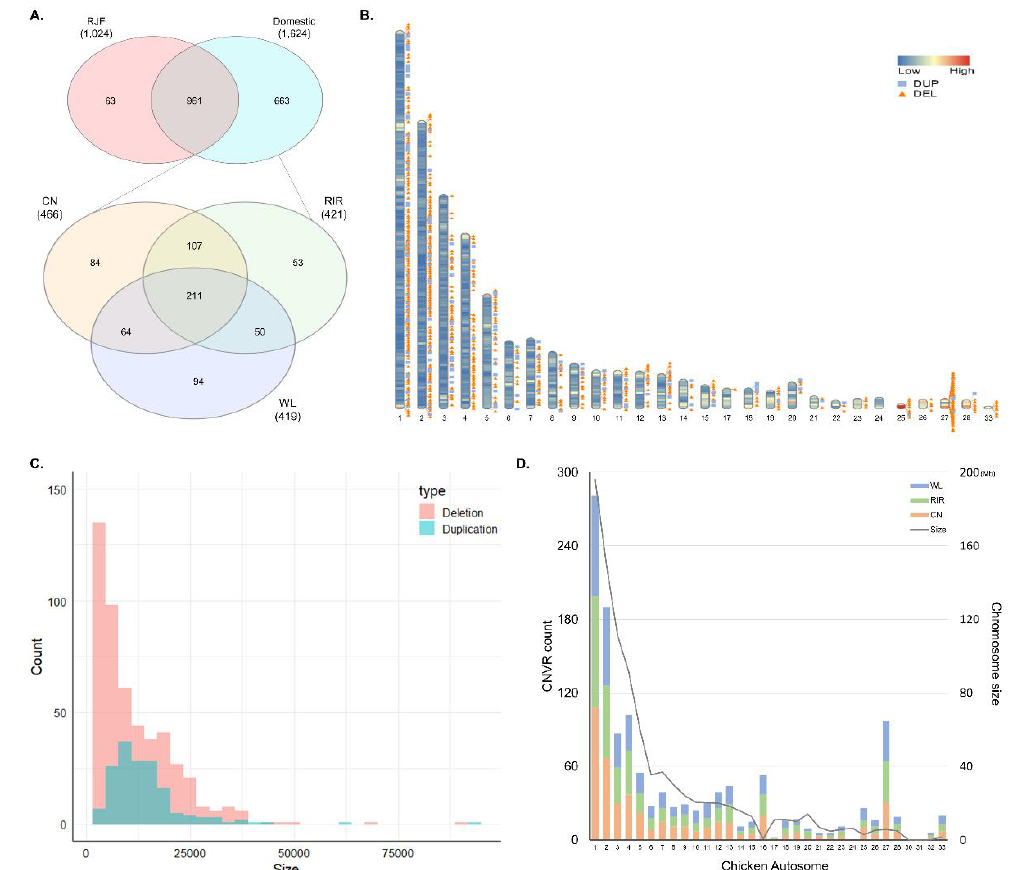
Figure 1. General description of the identified copy number variation regions (CNVRs). ( A ) Venn diagram for overlapping CNVRs between Red Jungle Fowl (RJF) and domesticated breeds (above), and among Cornish (CN), Rhode Island Red (RIR), and White Leghorn (WL) (below); ( B ) distribution of CNVRs on chromosome ideogram according to their state (deletion and duplication). This was drawn using Rideogram R package. The color painted on the chromosome represents the gene density; ( C ) distribution of CNVRs size by state; ( D ) chromosomal distribution of CNVRs for three chicken breeds and length of chicken autosome.